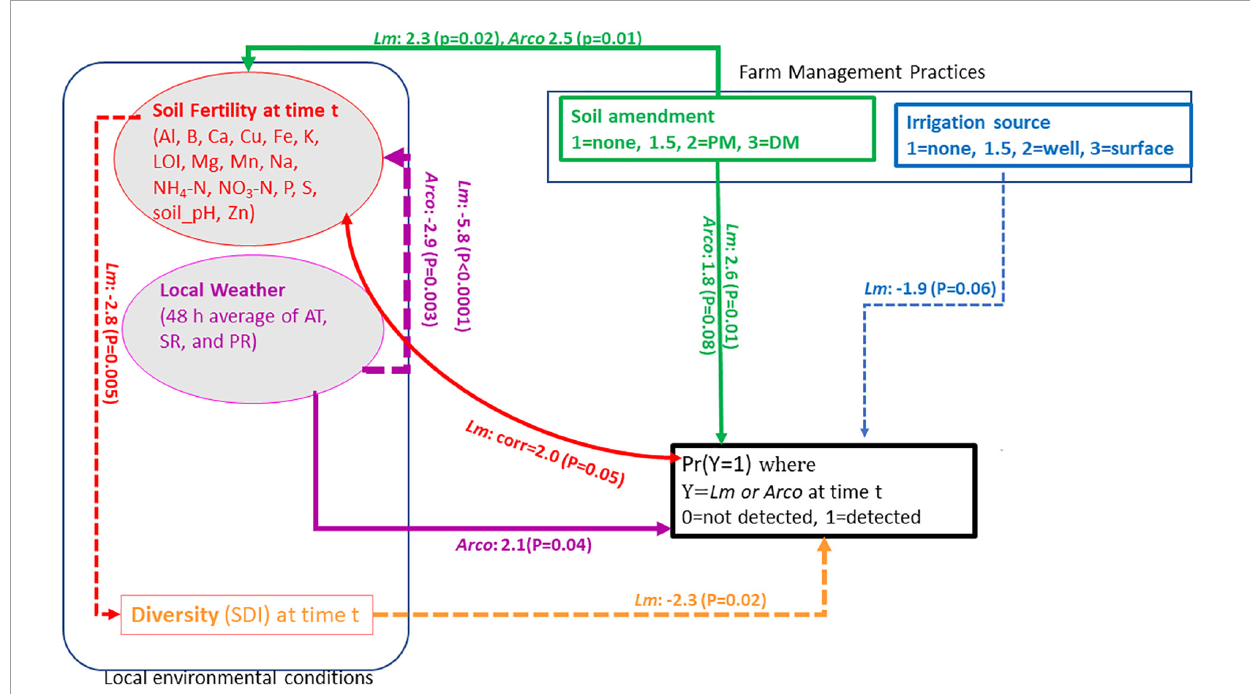
FIGURE5 Final (parsimonious) model for OH soil Lm and Arcobacter ( Arco ) prevalence. Numbers on single-headed arrows are the standardized regression path estimates ( z -statistic) and p -values (in parentheses). The thickness of the arrow reflects the strength of the relationship, with solid-line arrows indicating positive relationships and dash-line arrows indicating negative relationships. For plot simplicity, the soil nutrient covariances are provided in Supplementary Figure 2 . Al, aluminum; B, boron; Ca, calcium; Cu, copper; Fe, iron; K, potassium; Mg, magnesium; Mn, manganese; Na, sodium; P, phosphorus; S, sulfur; Zn, zinc; LOI, loss-on-ignition; PM, poultry manure; DM, dairy manure; AT, air temperature; SR, solar radiation; PR, precipitation; SDI, Simpson’s diversity index.